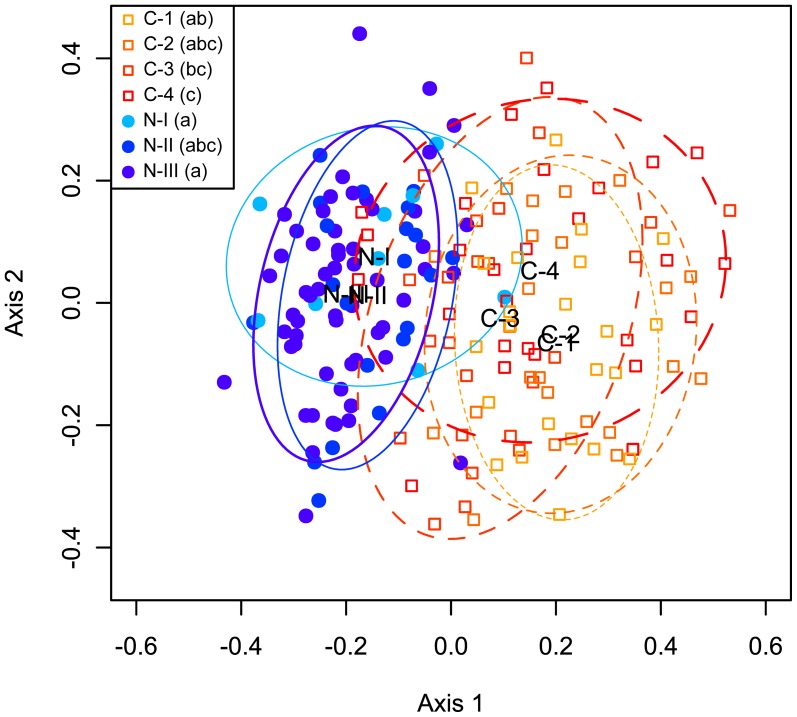
Principal component ordinations represent dissimilarity in assemblage patterns.The principal component ordinations are based on Sørensen indices. The dissimilarity in assemblage patterns between different age classes of clearcutting stands versus natural stands is shown. The first principal ordination axis was along the disturbance gradient and explained 38.7% of assemblage variation, and the second principal ordination axis as along the successional gradient and explained 14.3% of assemblage variation. The ellipses enclose 80% of the variability in compositional differences accounted by the first two ordination axes. Age classes that share the same letter (in the brackets) are not significantly different in their dispersion at α = 0.05, according to Tukey multiple comparisons. Age classes: C-1, C-2, C-3, and C-4: 5–19, 20–39, 40–59, and 60–70 year old clearcutting stands, respectively, N-I, N-II, and N-III: 50–79, 80–120, and >120 year old natural stands, respectively.